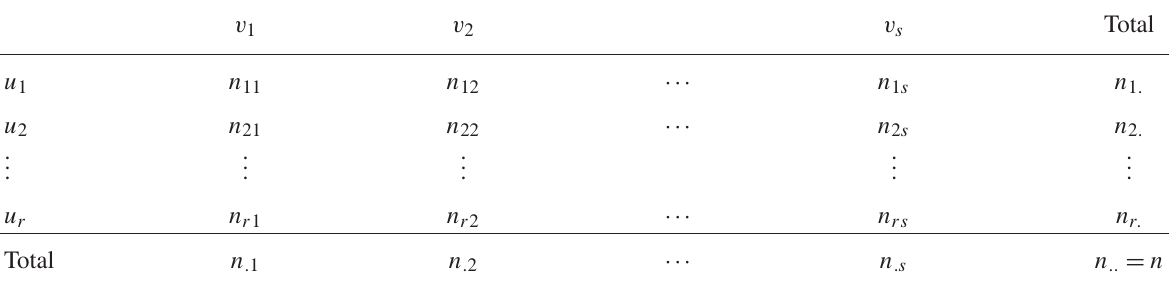
TABLE 1: Contingency table for two partitions of n